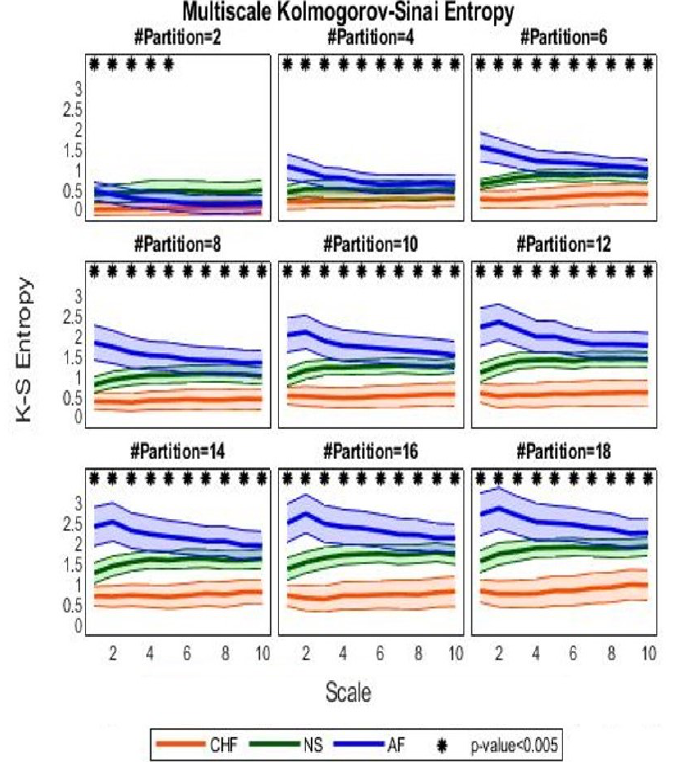
Figure 5. Median MKSE values as a function of scaling time. Orange lines refer to MKSE values extracted in the CHF group, green lines represent MKSE for healthy controls, and blue lines stand for the MKSE of arrhythmic HRV series. Thick lines indicate the median across subjects, whereas chromatic shaded areas represent the median absolute deviations. Each subfigure reports MKSE values (vertical axis) as a function of the time scaling τ (horizontal axis) for a different partition cardinality (even), increasing in the left-right and top-down directions from 2 to 18. Asterisks indicate the corrected p -value < α = 0.005 from a nonparametric group-wise Kruskal–Wallis